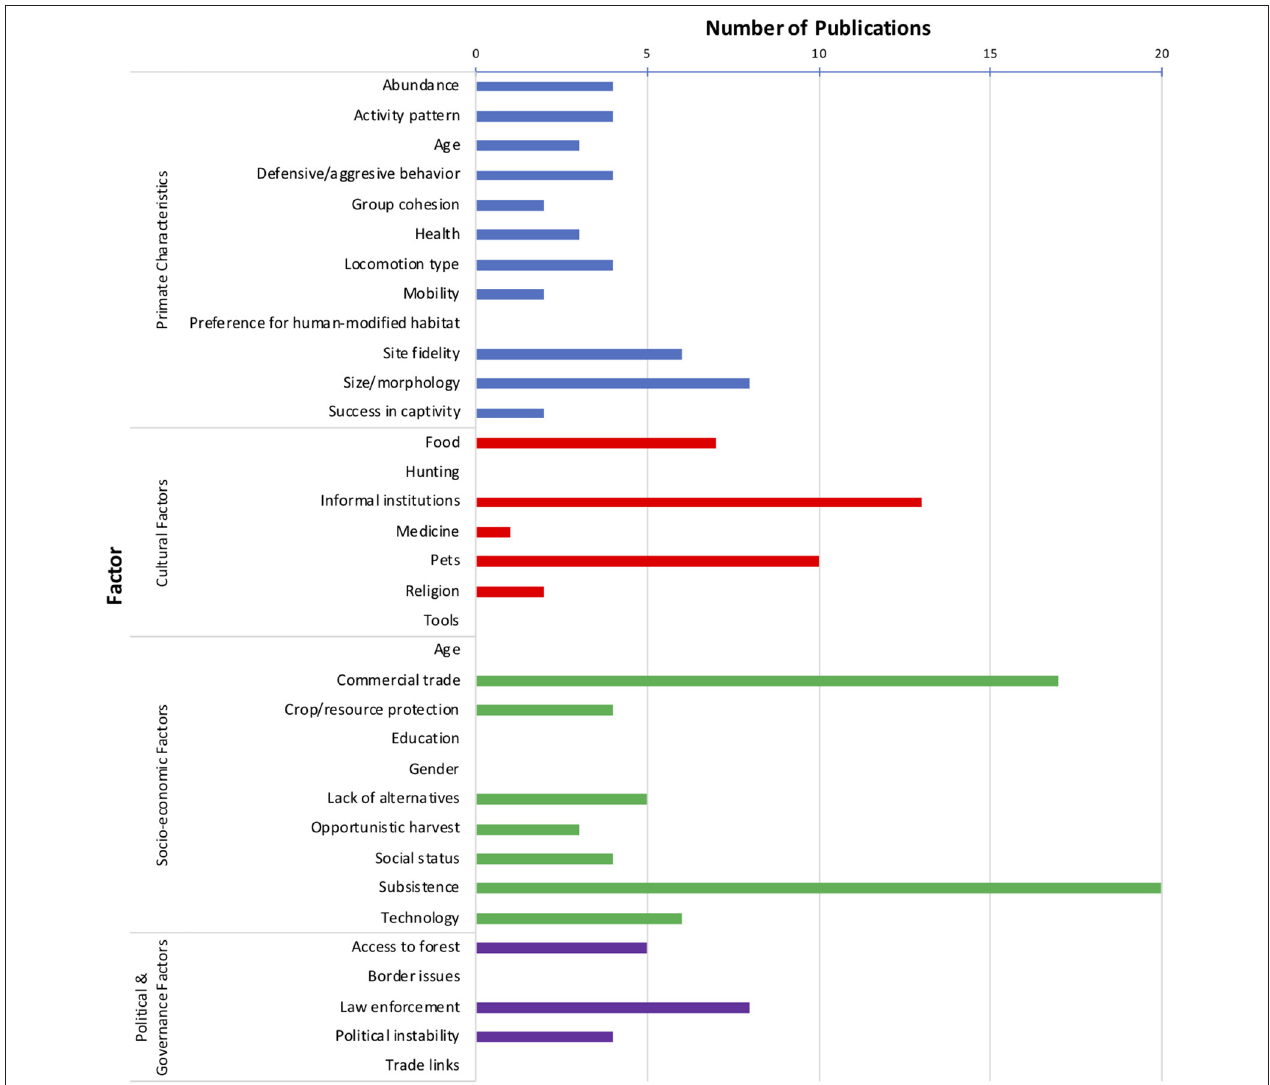
FIGURE 1 | Number of reviewed publications (total reviewed = 51) in which each factor affecting lemur harvest in Madagascar was identified. Refer to Table 1 for descriptions of each